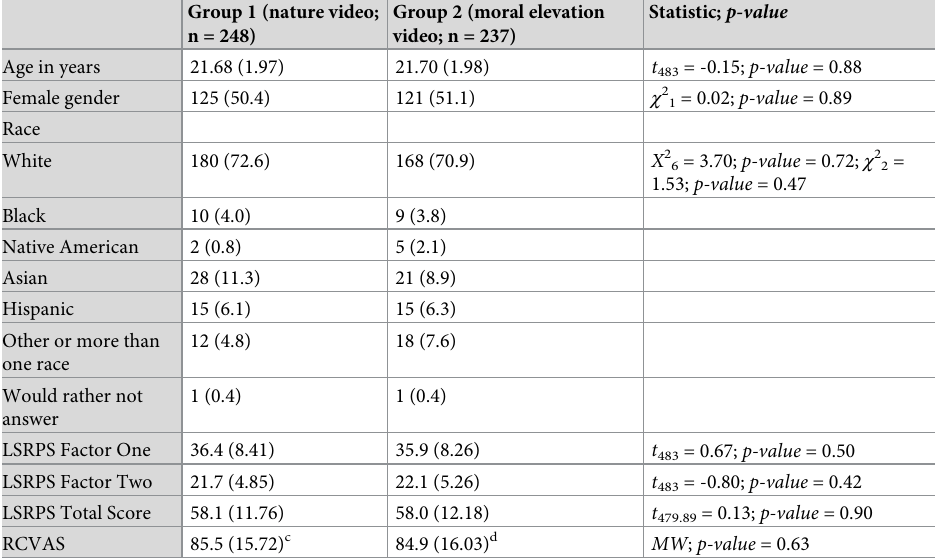
Table 1. Comparisons of subject characteristics by study group.